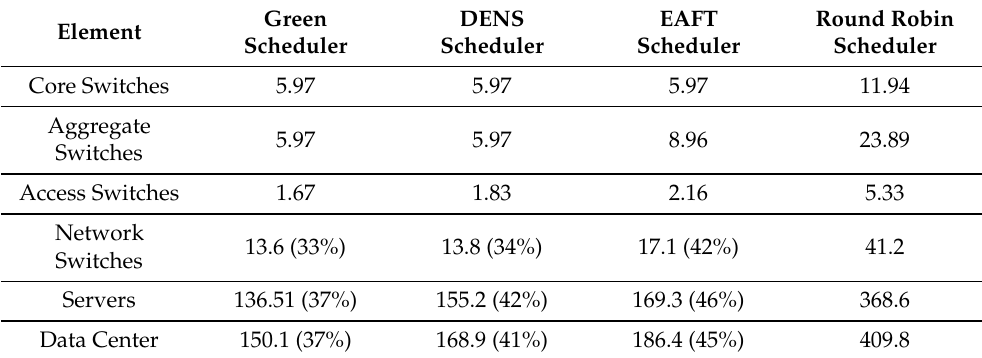
Table 3. Data Center Power Consumption in